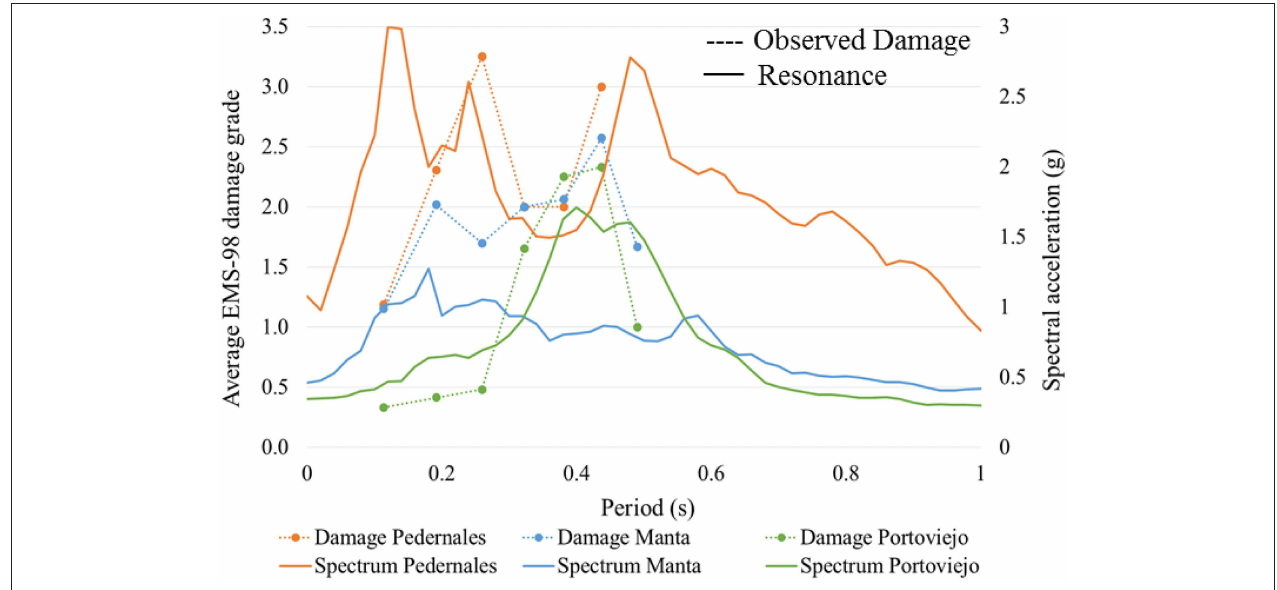
FIGURE 10 | Relationship between response spectra from recorded ground motions and surveyed building damaged (Franco et al.,